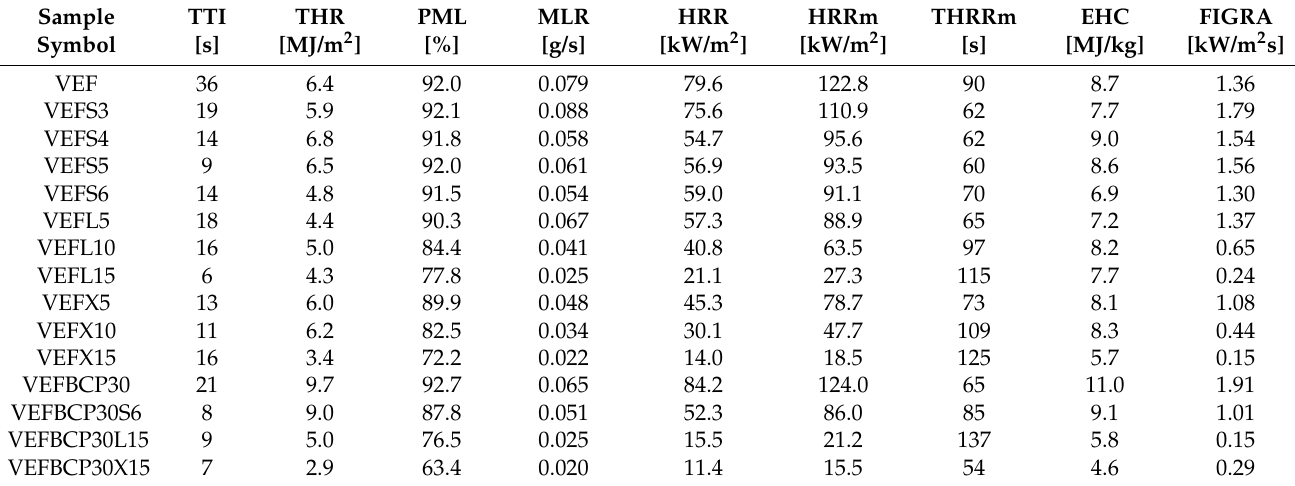
Table 9. Summary of the results of the analysis using the mass loss